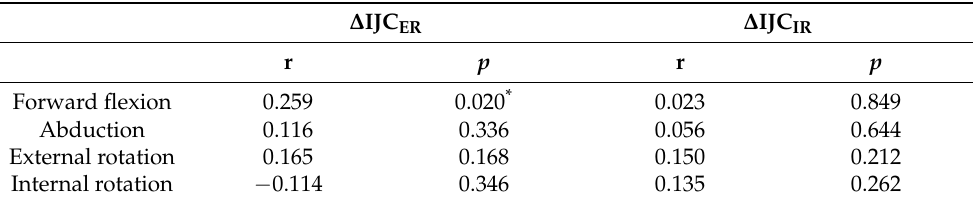
Table 4. Correlation between normalized dynamic changes in inferior joint capsule (IJC) thickness and range of